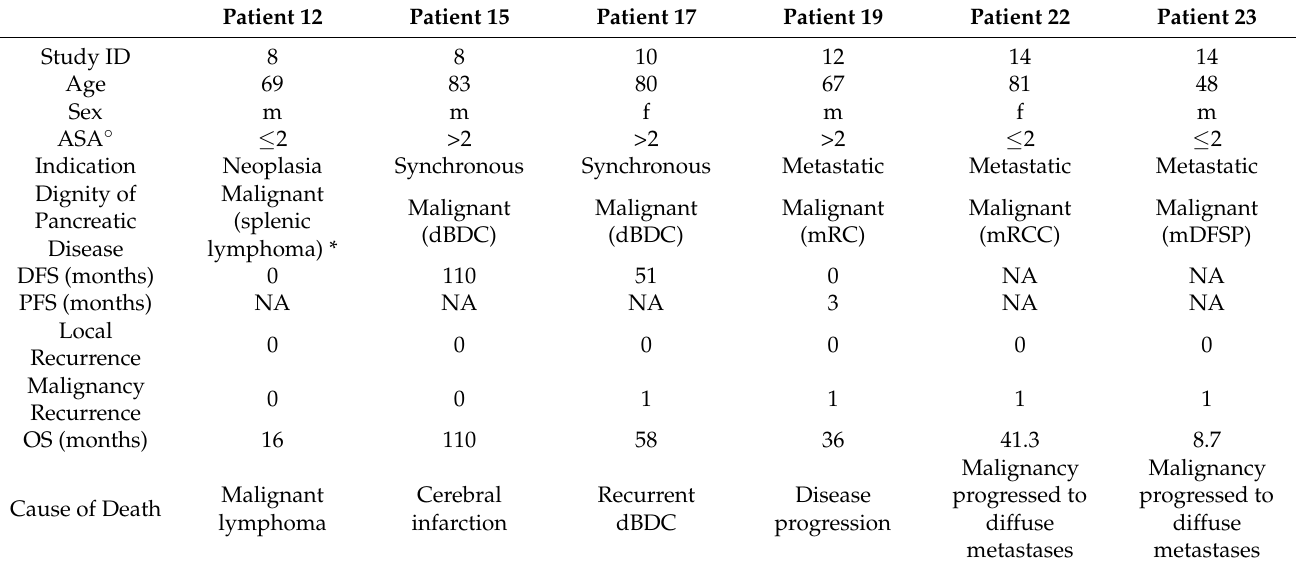
Table A10. Summary of survival and recurrence data for 6 MPP patients who died during